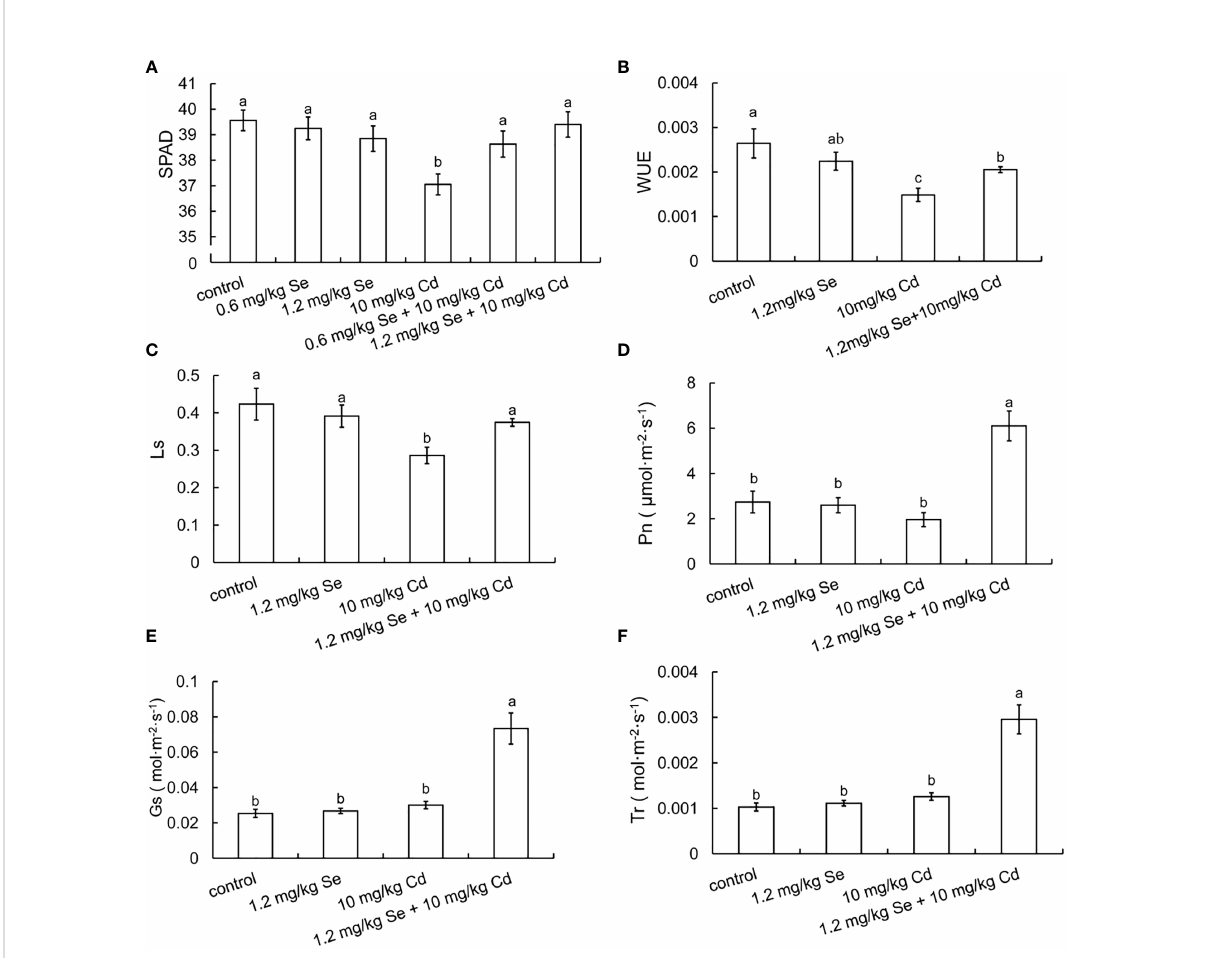
FIGURE 1 Effects of root exposure of Se on photosynthetic ef fi ciency of perilla seedlings under Cd stress (10 mg/kg). (A) SPAD; (B) water use ef fi ciency; (C) stomatal limit value; (D) net photosynthetic rate; (E) stomatal conductance; (F) transpiration rate. The different letters indicate signi fi cantly different values (P < 0.05 according to Duncan ’ s